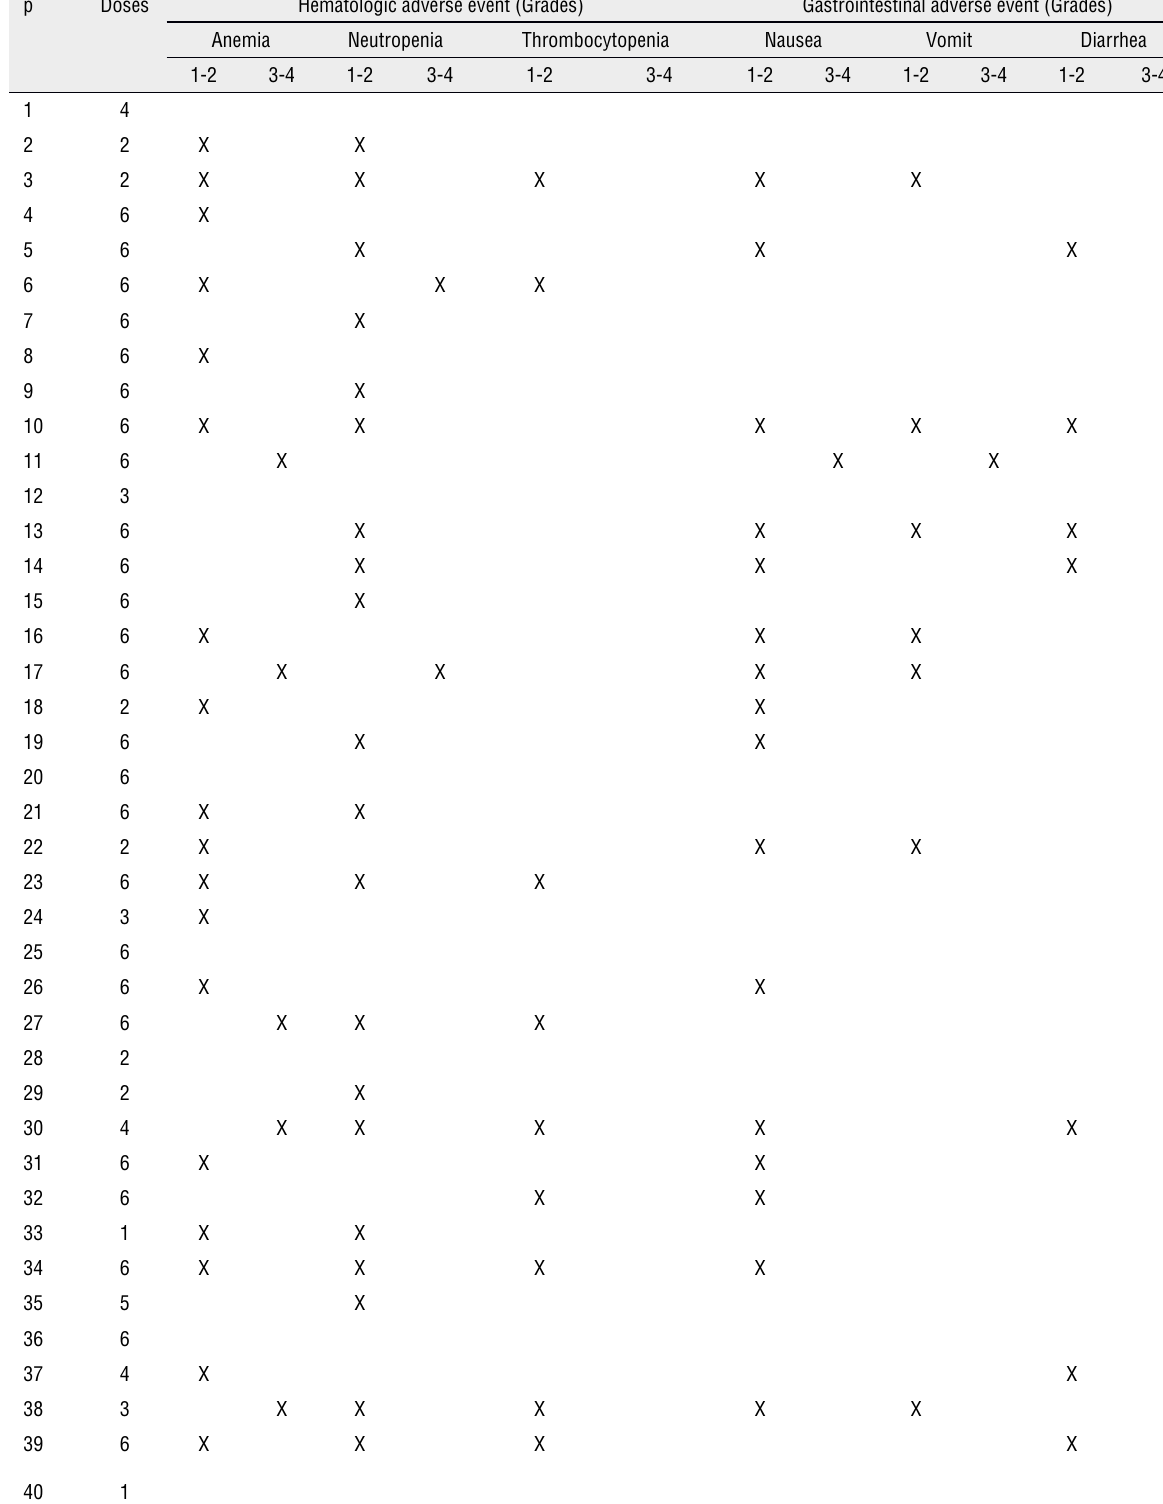
Table 5 - Adverse events graded according to the Common Terminology Criteria for Adverse Events, version 4.0. p